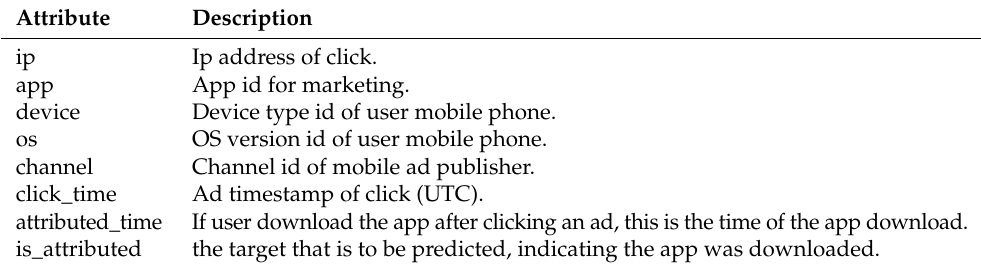
Table 5. Features in the TalkingData dataset.